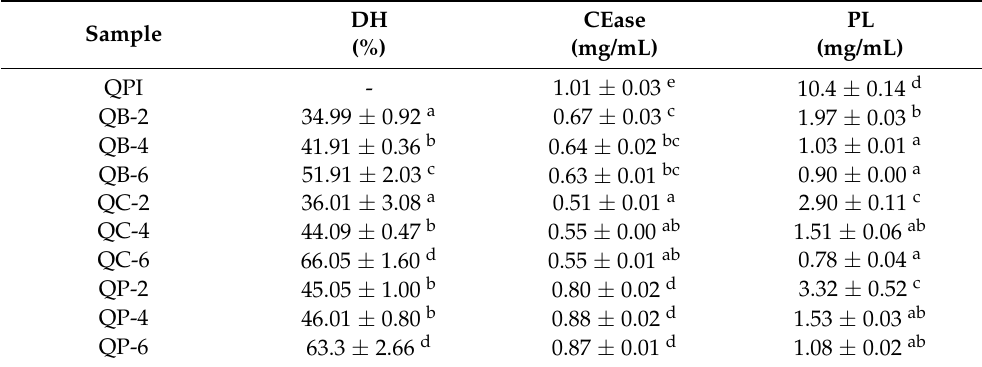
Table 1. DH, CEase and PL IC 50 inhibitory activities of quinoa protein hydrolysates generated by bromelain, chymotrypsin, and protease after hydrolysis